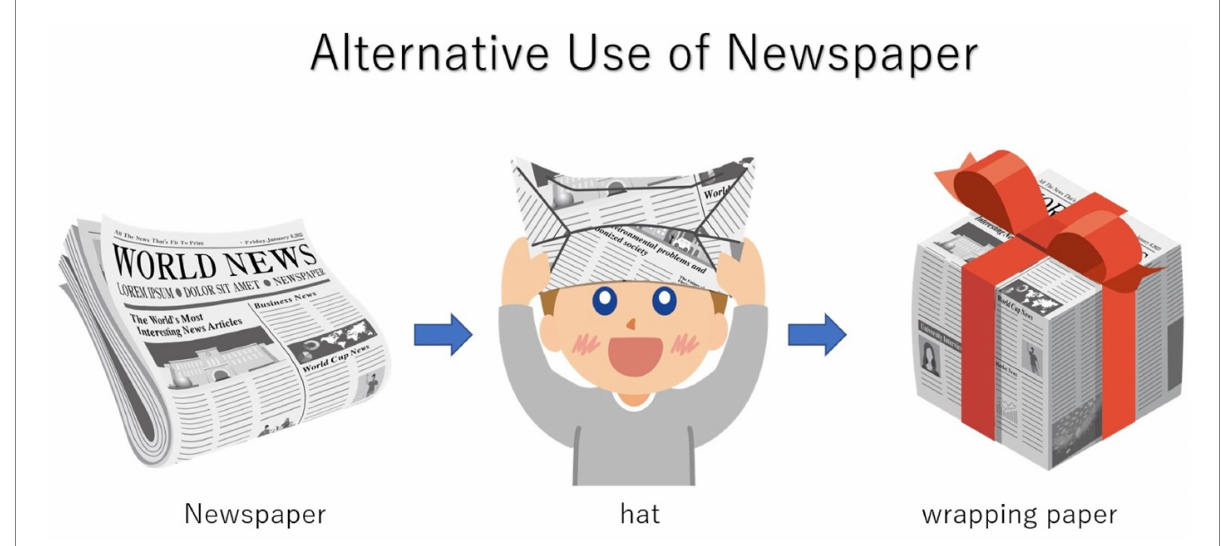
FIGURE 1 In the AUT, participants were asked to consider some common objects. Each object had a common use, which was stated in the answer sheets. They were asked to list other possible uses of the object or the part of the object. In this example, an object is a newspaper (used for reading). The alternative uses were listed as a hat and wrapping